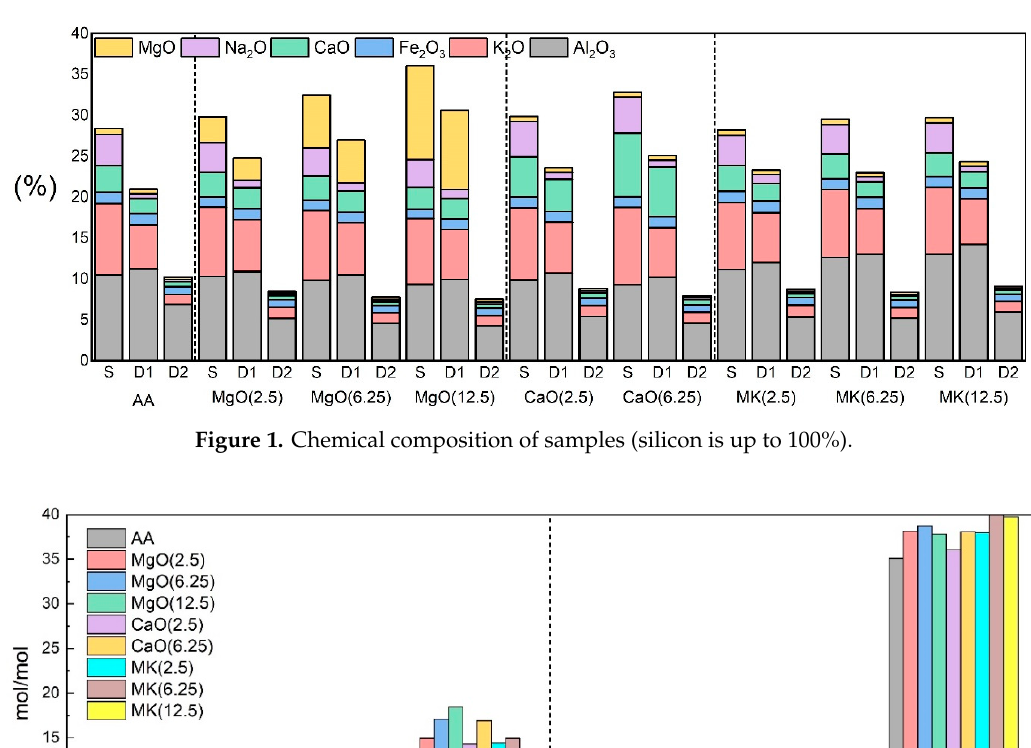
Figure 1. Chemical composition of samples (silicon is up to 100%).